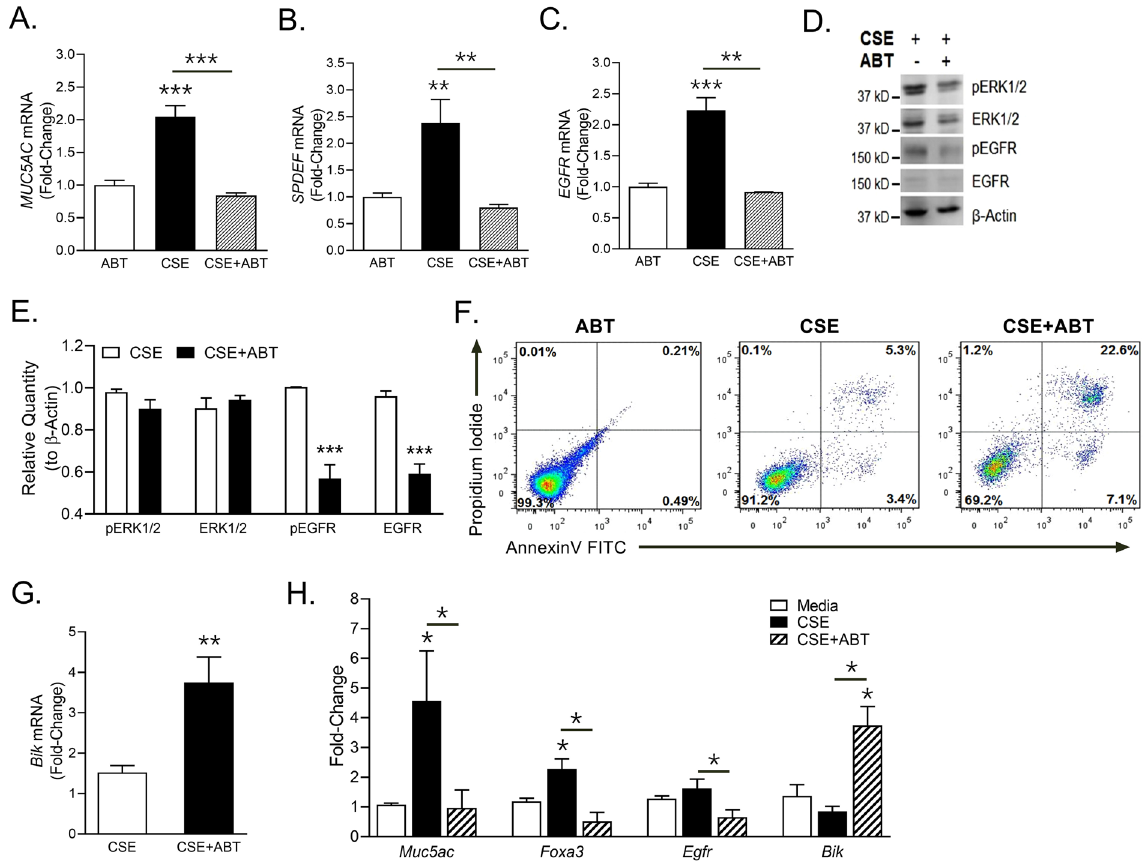
Figure 4. Blocking Bcl-2 with ABT-263 suppresses the CSE-induced mucous phenotype by suppressing EGFR signaling and inducing apoptosis and Bik expression. ABT-263 treatment suppresses CSE-induced MUC5AC ( A ), SPDEF ( B ) and EGFR ( C ) mRNA levels. Differentiated human AECs were treated with 1 µ M ABT-263 for 2 h before treating with 10 µ g/ml CSE and cells were harvested at 48 h post treatment. ( D ) Immunoblot analyses of pERK1/2, ERK1/2, pEGFR and EGFR following CSE exposure and ABT-263 treatment of differentiated human AECs. ALI-differentiated human AECs were treated with ABT-263 (1 µ M) for 2 h before treating with 10 µ g/ml CSE and cells were harvested at 48 h post treatment. ( E ) Relative quantities of pERK1/2, ERK1/2, pEGFR and EGFR as determined by densitometric analysis with protein quantities normalized to β -actin levels. ( F ) ABT-263 treatment augments apoptosis in CSE-exposed human AECs. Differentiated human AECs treated with ABT-263, CSE and CSE + ABT were harvested at 48 h post treatment, and analyzed for Annexin V-FITC and propidium iodide staining by Flow cytometry. ( G ) ABT-263 treatment induces the proapoptotic Bik mRNA levels that are suppressed by CSE exposure. ( H ) ABT-263 treatment of differentiated murine AECs suppresses the CSE-induced mucous secretory phenotype by modulating cell survival/death pathways. Primary murine AECs differentiated for 3 weeks on ALI were treated with ABT-263 (1 µ M) and/or CSE (10 µ g/ml) and the mRNA levels of Muc5ac, FoxA3, Egfr and Bik were analyzed by qRT-PCR. Data shown as mean ± SEM (n ≥ 3); * p < 0.05; ** p < 0.01; *** p <